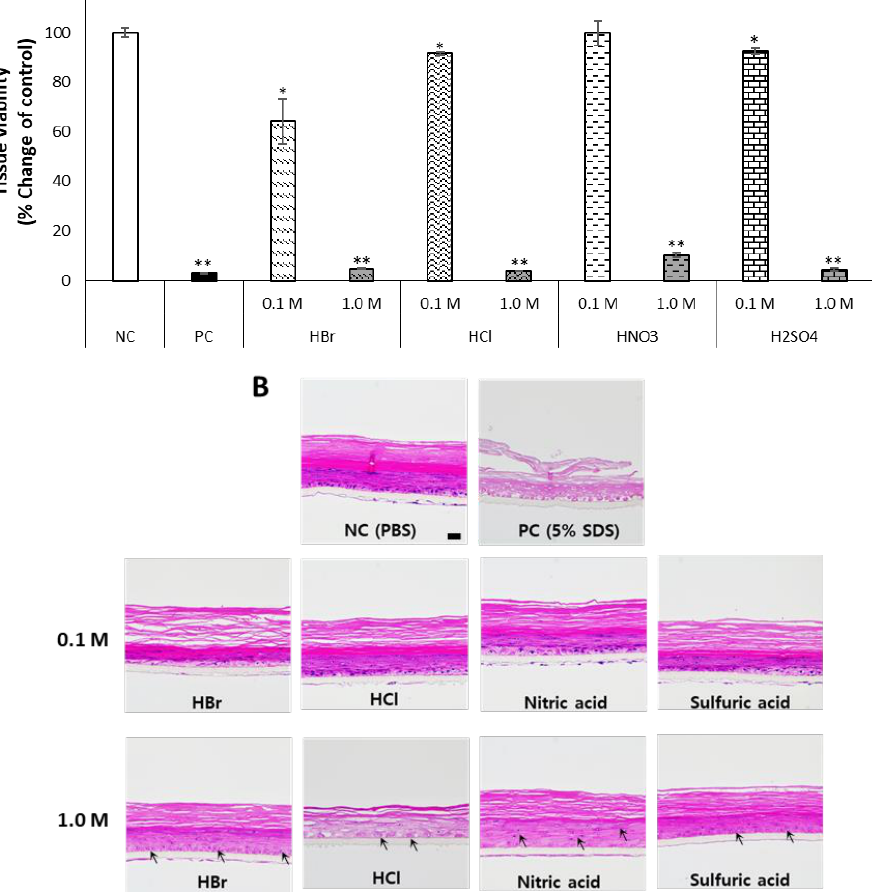
Figure 3. Inorganic acids were prepared at a low concentration (0.1 M) and a high concentration (1.0 M) in DW and exposed to KeraSkin™ for 30 min. Then, ( A ) cell viability was evaluated, and ( B ) skin tissues were stained with H&E. Scale bar is 50 μm. NC; negative control (DW) with white bars, PC; positive control (5% SDS) with filled bars. Tested samples with patterned bars, HBr; hydrogen bromide, HCl; hydrogen chloride, HNO 3 ; nitric acid, H 2 SO 4 ; sulfuric acid. Arrows show vacuolization and pyknosis. * p < 0.05, ** p < 0.01.